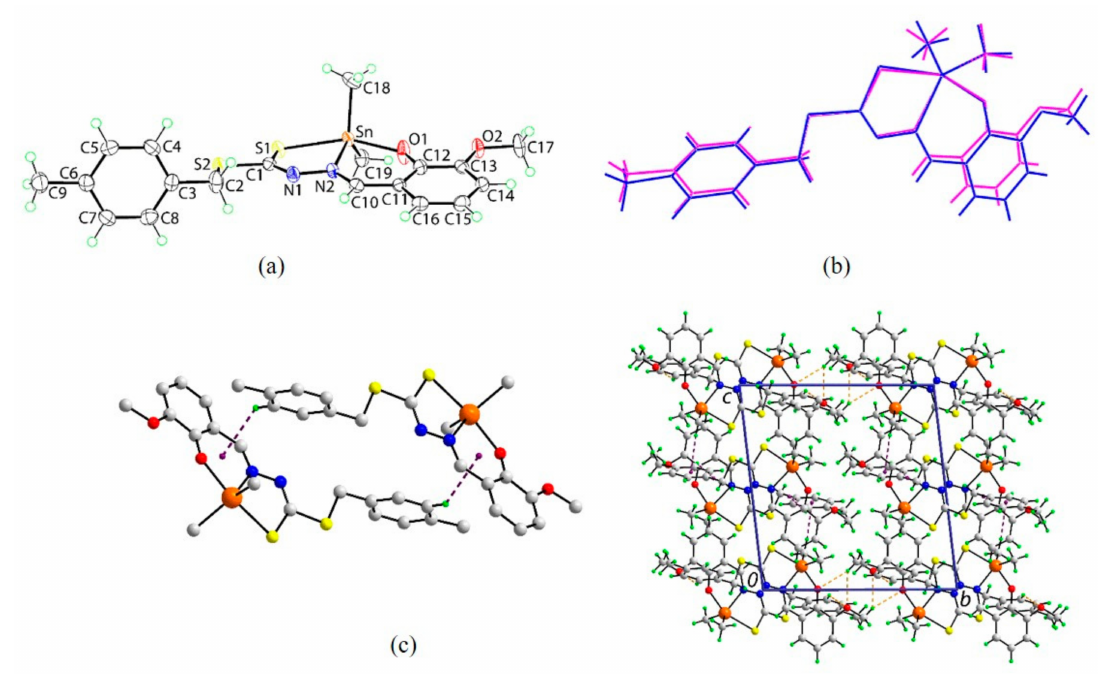
Figure 4. Crystallographic diagrams for Me 2 Sn(S4MoVa): ( a ) Molecular structure of the second independent molecule, molecule b, ( b ) overlay diagram of molecules a (blue image) and inverted-b (pink) drawn so the SnC 2 atoms of the Me 2 Sn moiety are overlapped and ( c ) a view of the supramolecular dimer sustained by C–H ... π (chelate) interactions (left image; non-participating hydrogen atoms have been omitted) and a view of the unit cell contents in projection down the